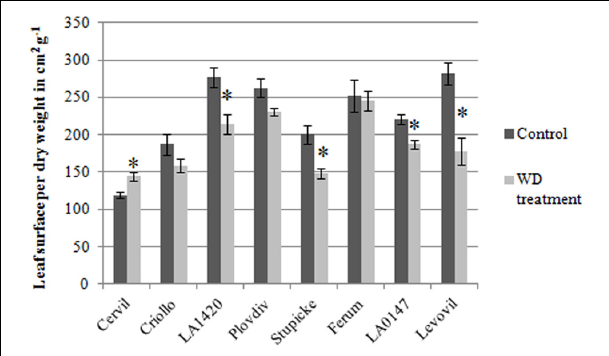
FIGURE 2 | Specific leaf area of the eight parents of the MAGIC TOM, measured at the end of the trial (control and WD treatments). Data are means ± SE ( n ≥ 5). Significant differences between control and WD treatments are indicated by stars for P < 0.05 (Student test performed for each